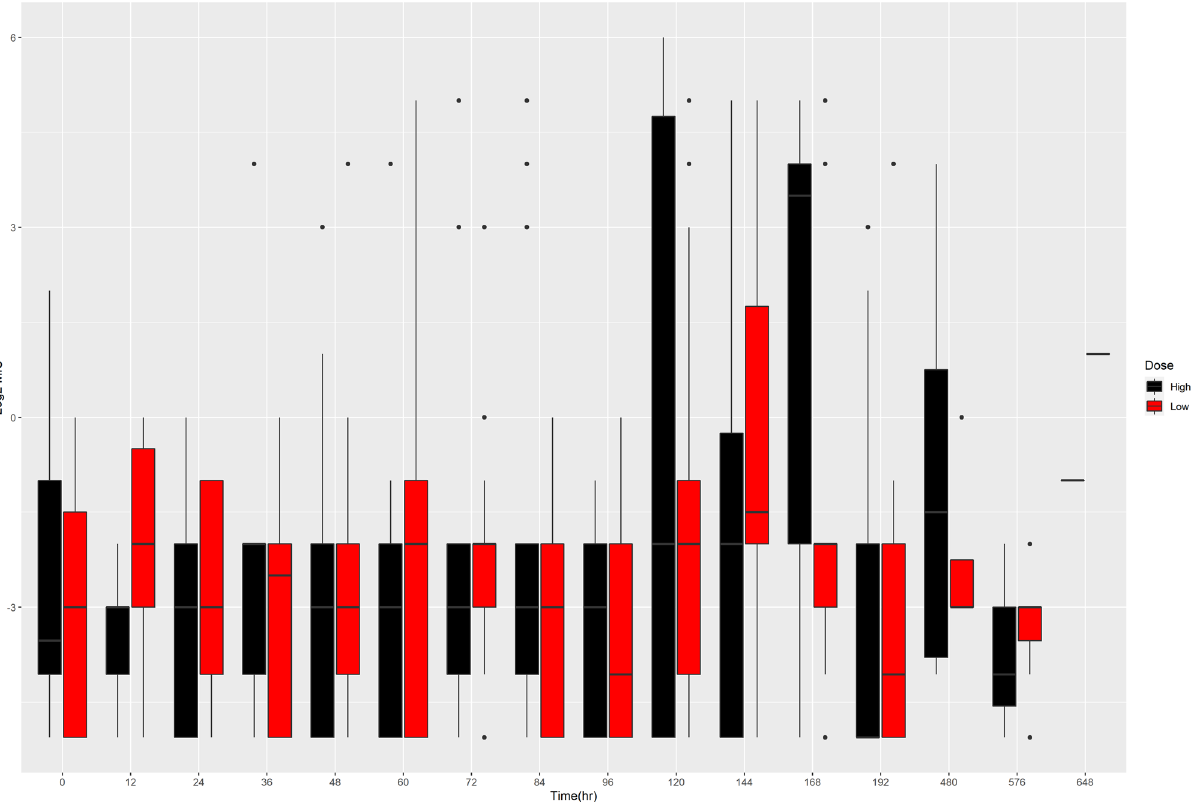
Figure 7. Log2 MIC over time of Enterococcus hirae per dosing group. The high dose group is shown in black and the low dose group is shown in red. The data is presented as boxplots with the upper and low quartiles present. Outliers are shown as individual black